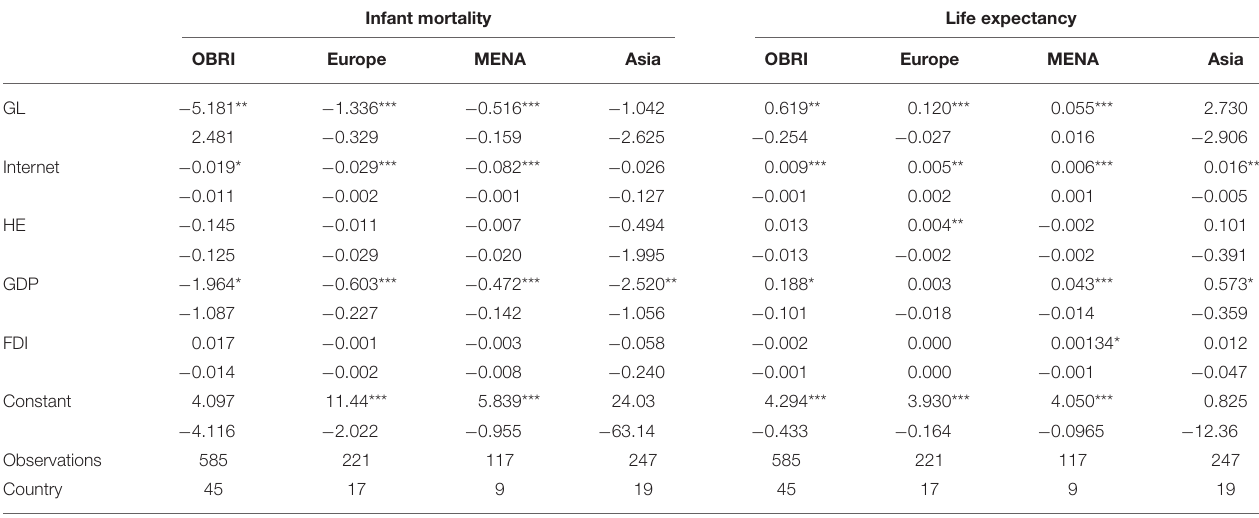
TABLE 3 | Health outcomes (2SLS).